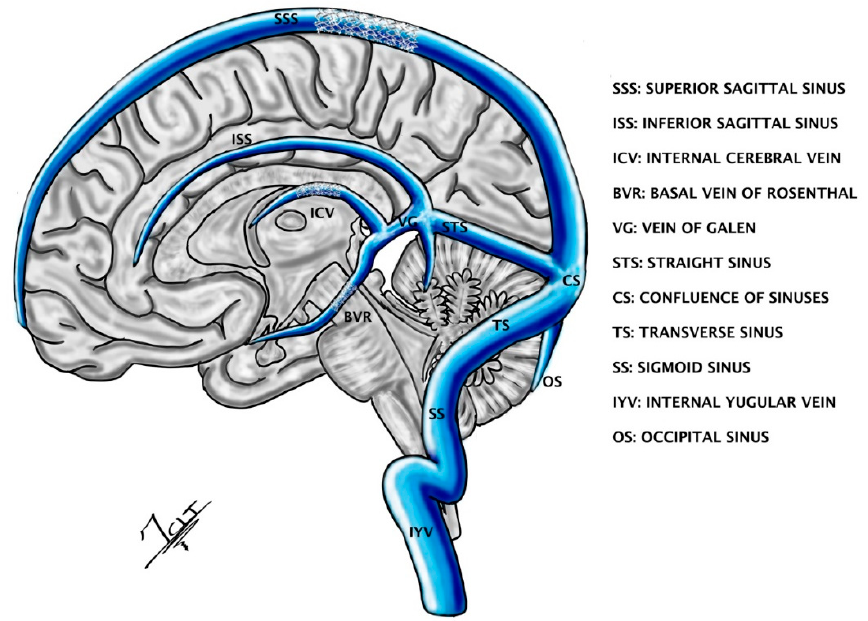
Figure 4. This figure shows some theoretical locations (superior sagittal sinus, internal cerebral vein and basal vein of Rosenthal) of STENTrodes which can be placed by the endovascular transvenous approach to stimulate the cortex, thalamus or brainstem nuclei. Illustrated by J.